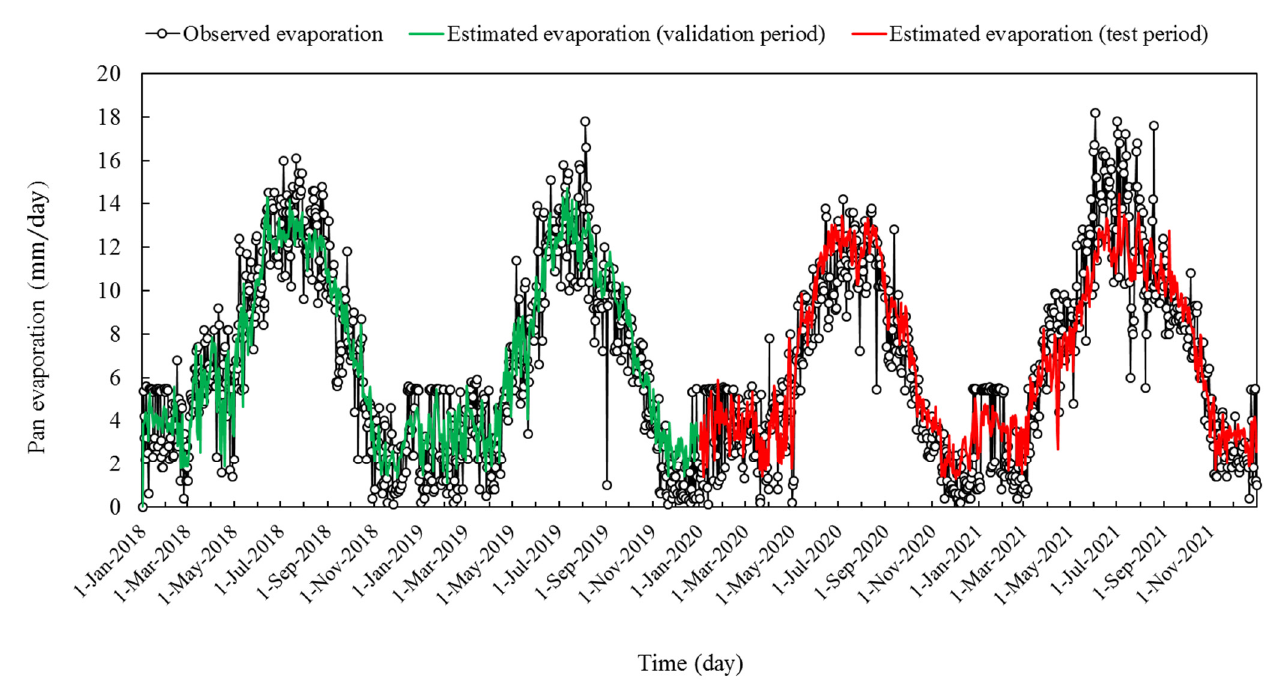
Figure 5. Time series plots of the MLP outputs learned by Levenberg–Marquardt algorithm, and the observational pan evaporation. Table 4. Evaluation metrics for the pan evaporation modeling of MLP, learned by Bayesian regu ‐ larization algorithm (MLP ‐ BR).